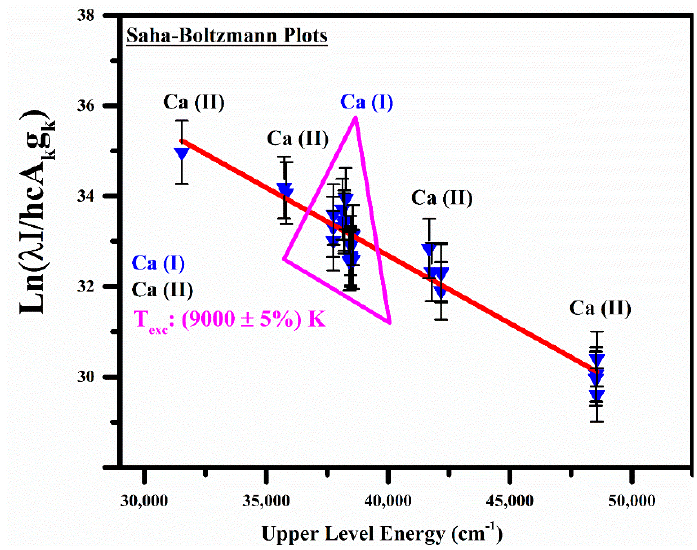
Figure 3. Saha–Boltzmann plots using the well-isolated Ca (I) and Ca (II) spectral lines.